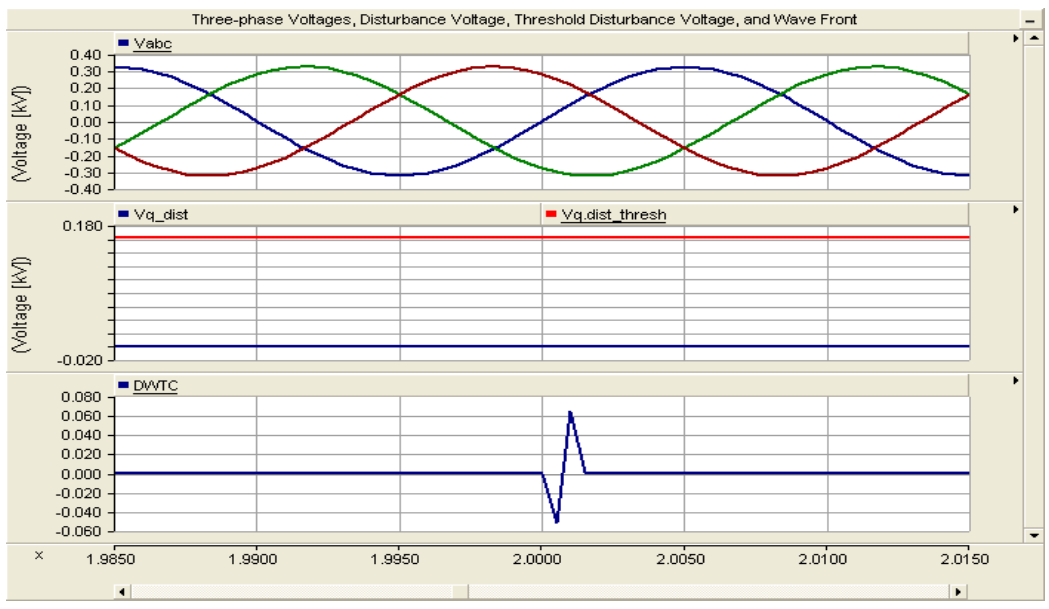
Figure 4. 3-phase voltage, disturbance voltage, and discrete wavelet coe ffi cient (DWTC) of current transient during